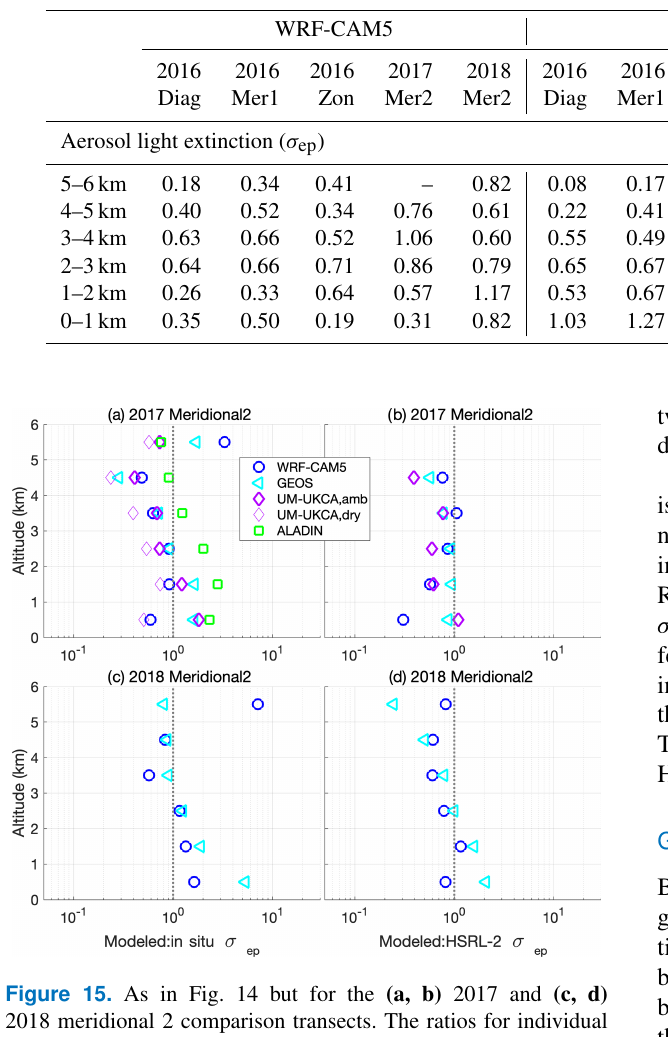
Table 2. As in Table 1 but for retrieved values of σ ep only from the HSRL-2 lidar on board the ER-2 aircraft in 2016 and the P-3 aircraft in 2017 and 2018. Both modeled and observed values are at ambient RH. The modeled values are 550nm, and the HSRL-2 values are at 532nm.